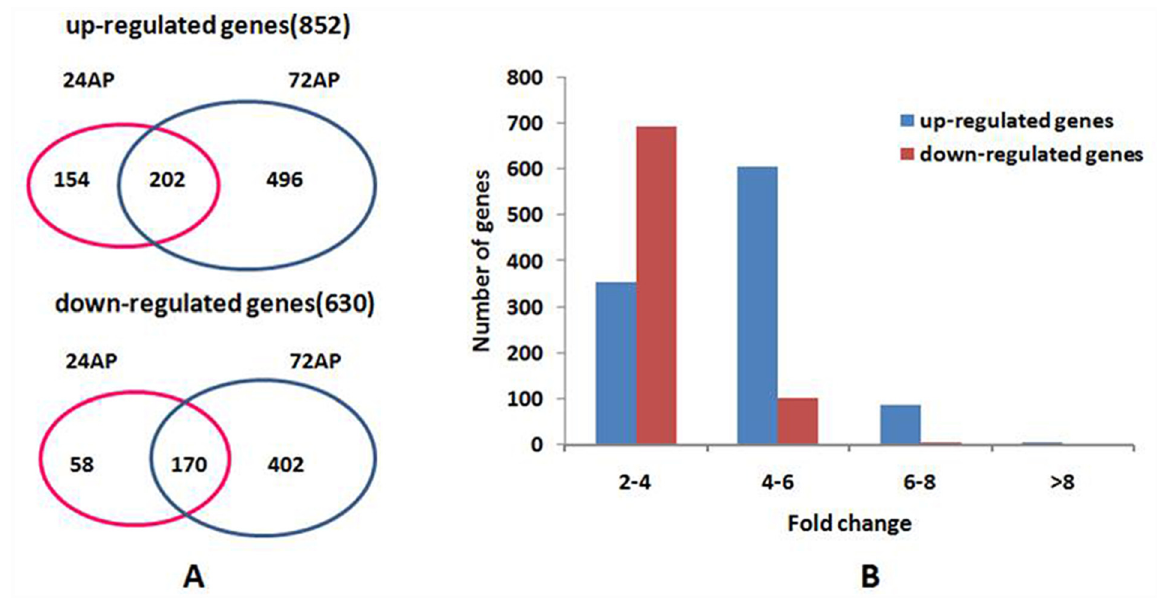
Fig 3. GO annotation of differentially expressed genes at 24APand 72AP (level 2). At 24AP, the program categorized 390 unigenes in the cellular component category, 297 unigenes in the molecular function category, and 542 unigenes in the biological process category. At 72AP, the program categorized 732 unigenes in the cellular component category, 580 unigenes in the molecular function category, and 971 unigenes in the biological process category.